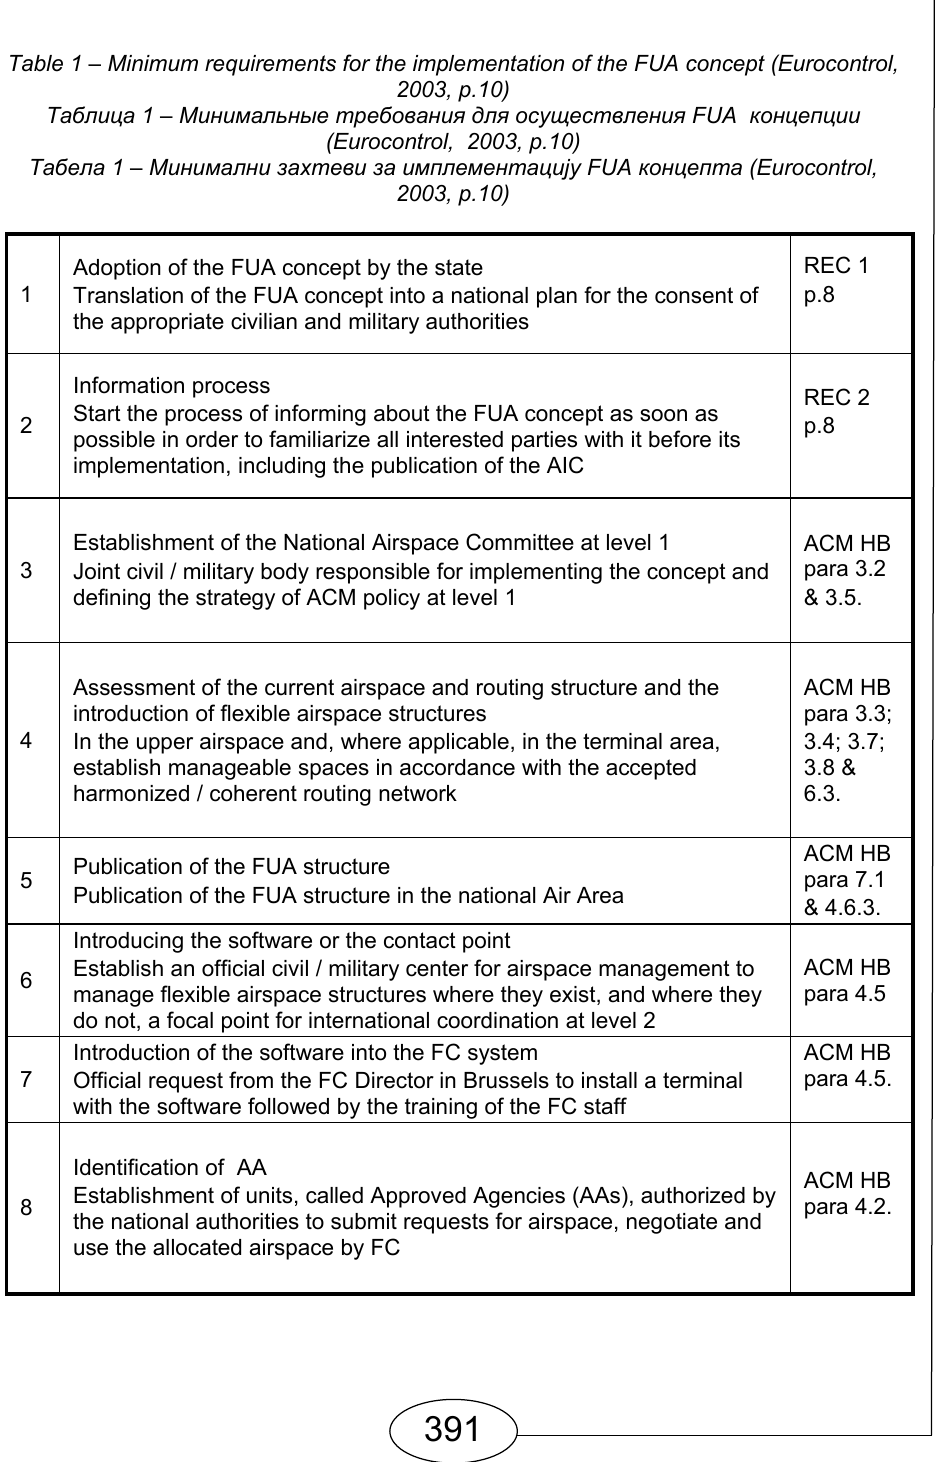
402 Table 1 – Minimum requirements for the implementation of the FUA concept (Eurocontrol, -